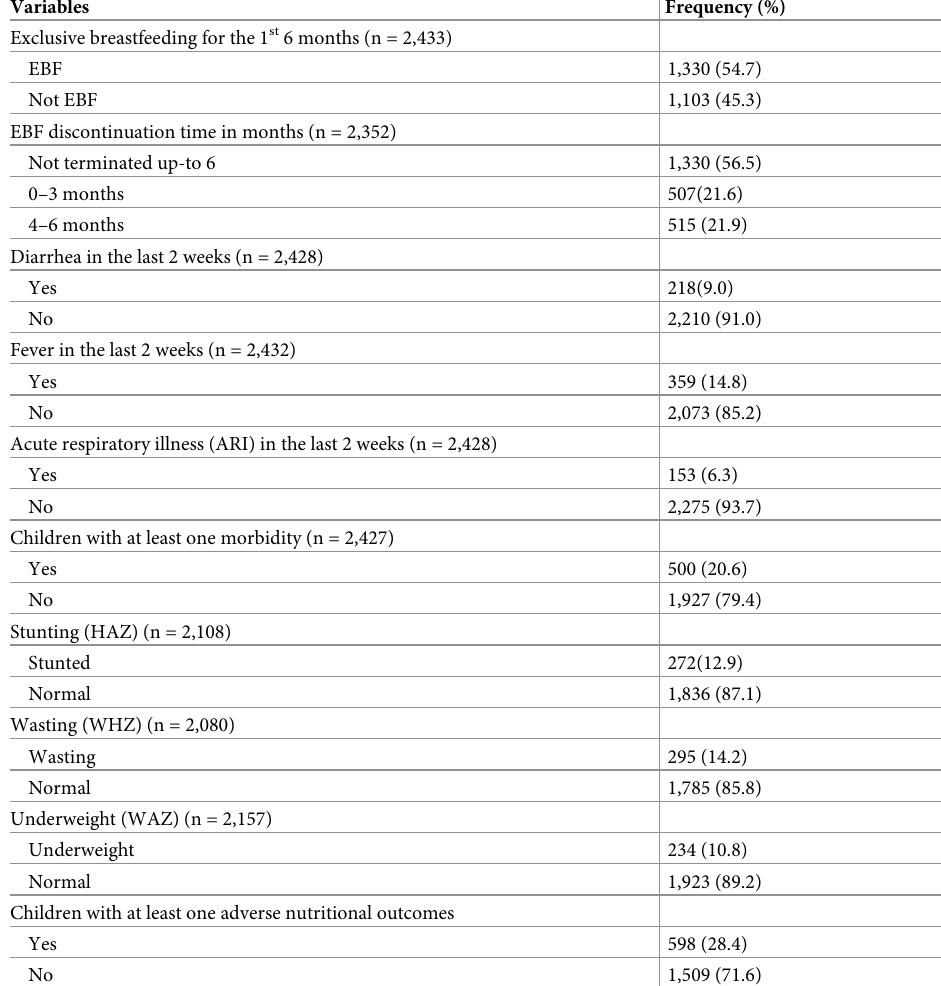
Table 2. Breastfeeding, morbidity and nutritional status of under six month’s children, 2011 and 2016 EDHS, Ethiopia.